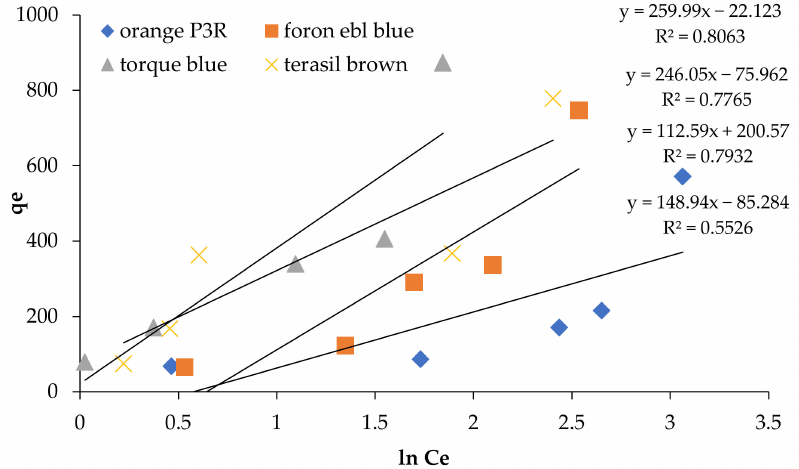
Figure 8. Temkin Isotherm at 5 concentrations for non-calcinized